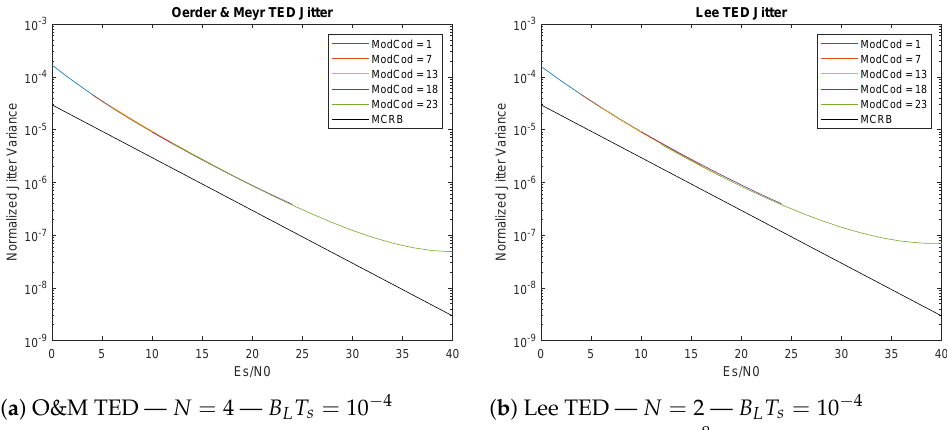
( b ) Lee TED — N = 2 — B L T s = 10 − 4 Figure 13. Oerder and Meyr TED and Lee TED jitter evaluation (5 × 10 8 transmitted symbols). Apart from jitter related consideration, it should be also pointed out that feedforward timing error detectors need additional logic to correct the estimates, which are limited to τ ∈ ( − 0.5 T s ; 0.5 T s ] . When error falls out this range, the output may be effected by and error equal to T s with respect to the current sampling basepoint. Structures that aim to compensate this may be based on the cyclic nature of this effect in the presence of ramp-like timing error, or using an unwrapping technique to extend the range. The first one is also based on a feedforward structure, while unwrapping is based on a feedback structure. In the presented receiver architecture, the unwrapping technique is used because it provides finer control. This is due to the fact that it is based on actual real-time estimates and not a long-term approximation of the general nature of